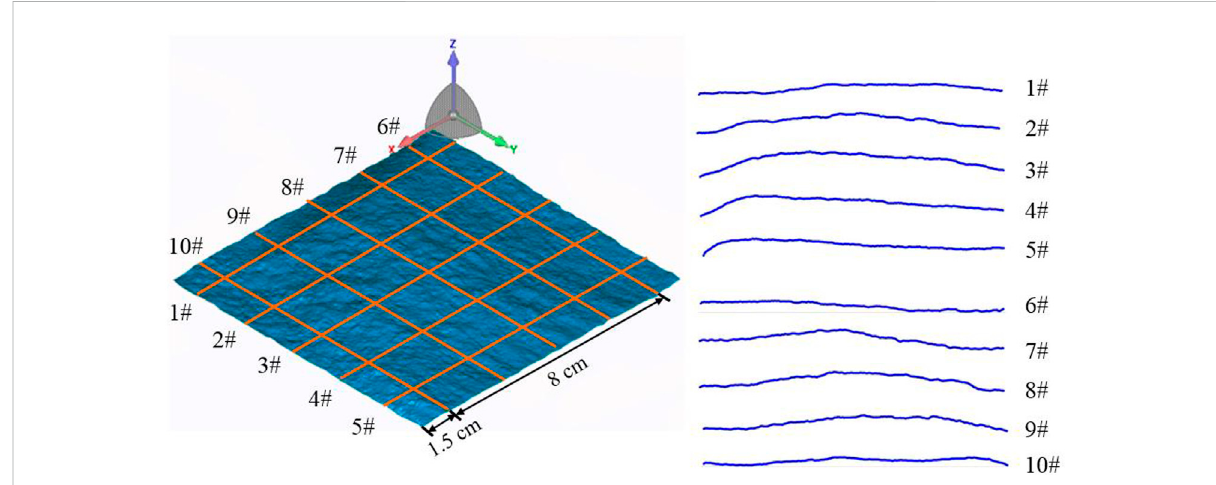
FIGURE 4 Point cloud data of the rough structural plane and layout of survey line.